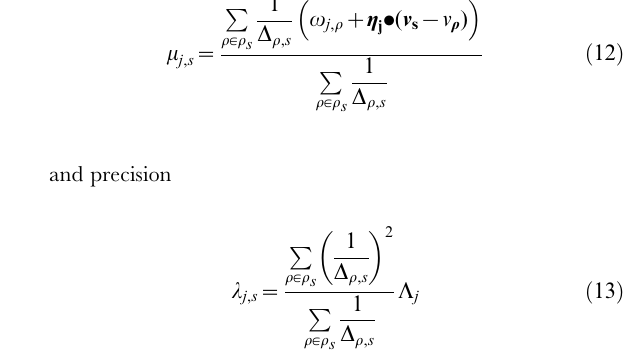
Table 1. miRs with a significant estimate for the trend